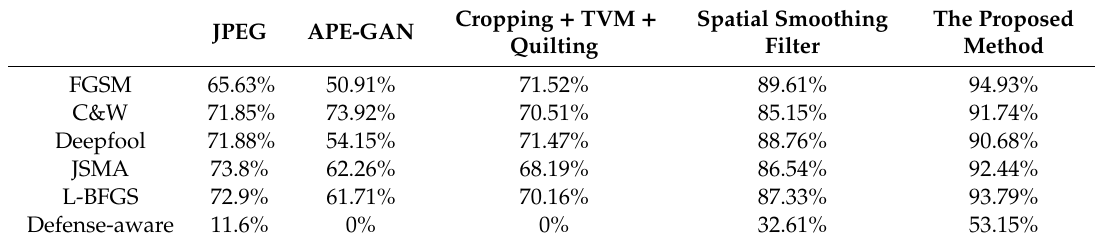
Table 5. The results of performance comparison